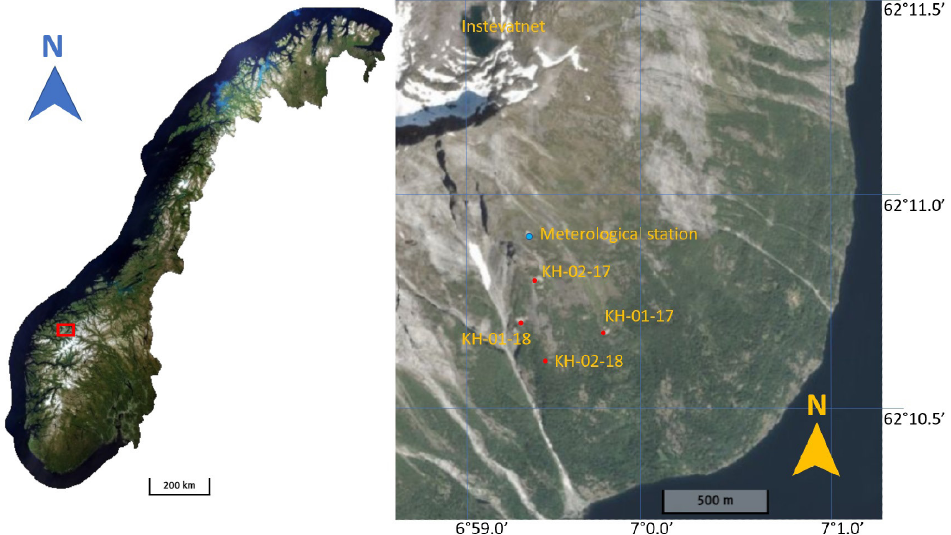
Figure 1. Maps of Åkneset from Kartverket (2021). Left: Åkneset, Norway labelled; Right: Overview of the boreholes at Åkneset considered in this study: boreholes are marked by red dots and their names are given in yellow. A blue dot shows the location of Åknes meterological station (c. 900 amsl). North is shown by the yellow arrow. Instevatnet (a lake) is also show in the upper left